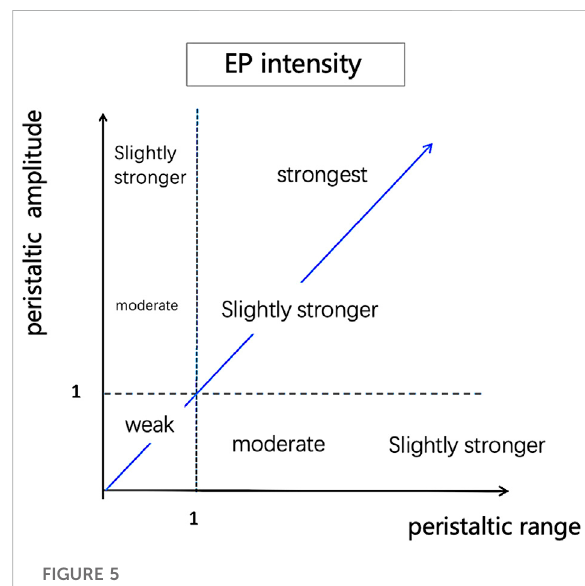
FIGURE 5 Quantitative assessment of EP intensity. Calculate each peak on the peristaltic wave curve and generate a point with peristaltic range on the x-axis and peristaltic amplitude on the y-axis in the coordinate